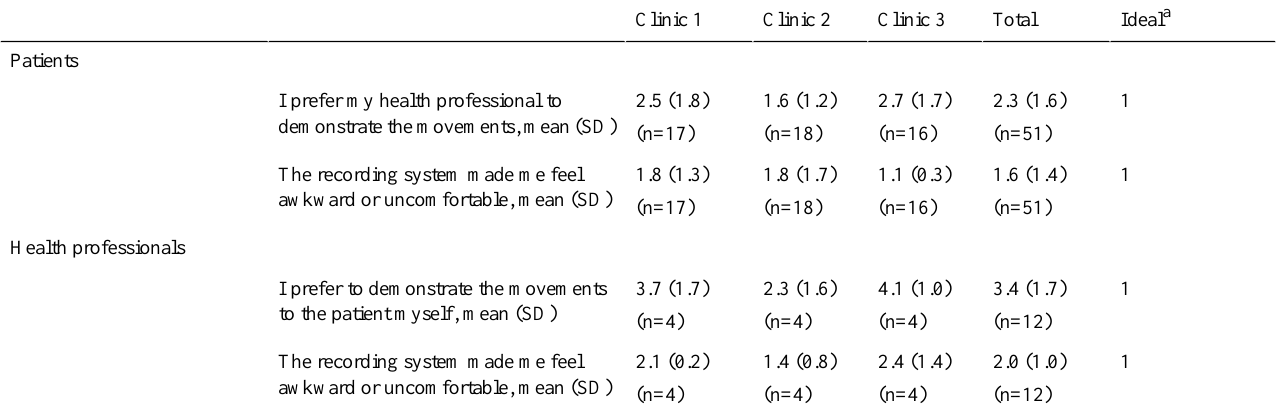
Table 8. Questionnaire data for acceptability metric